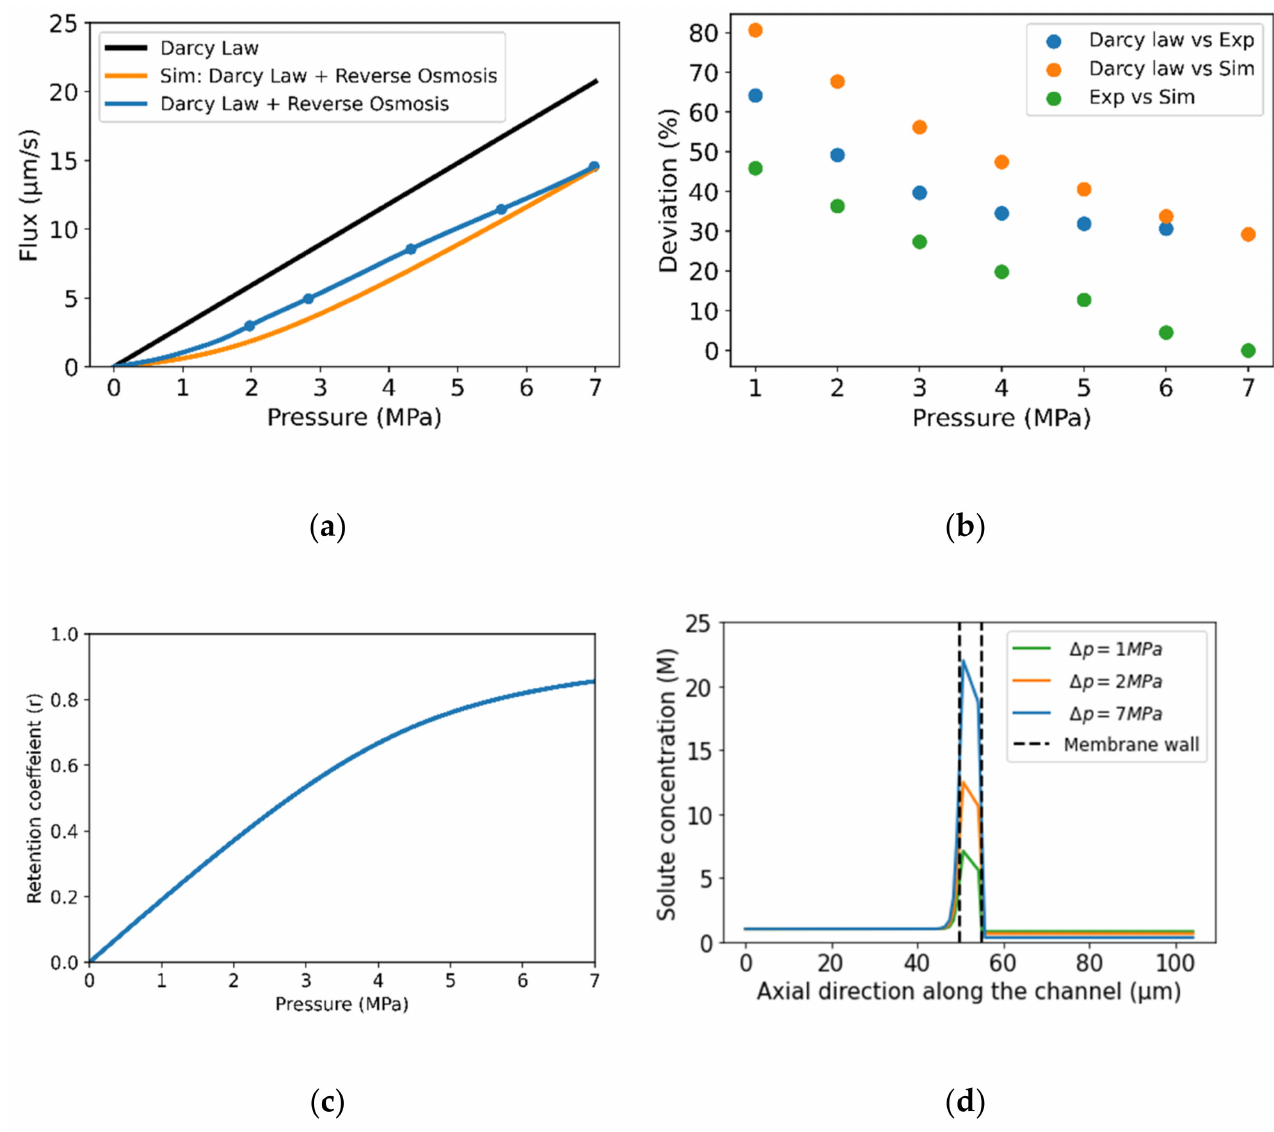
Figure 4. ( a ) Comparison of Darcy law (without the effect of reverse osmosis) and the experimental and numerical results (with the effect of reverse osmosis). ( b ) Percentage deviation of experimental and simulated results from the Darcy law. ( c ) Simulated retention coefficient ( r ) at different pressure differences. ( d ) Distribution of solute in the simulated geometry Table 2. Parameters of the numerical